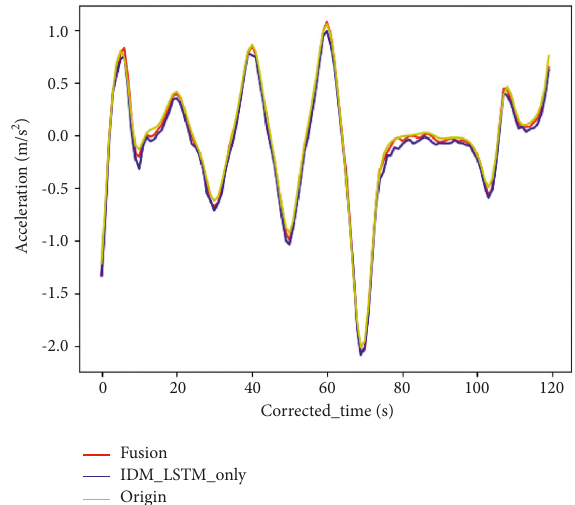
Figure 10: Car-following sampled acceleration of ID 121 generated by IDM-informed LSTM and fusion